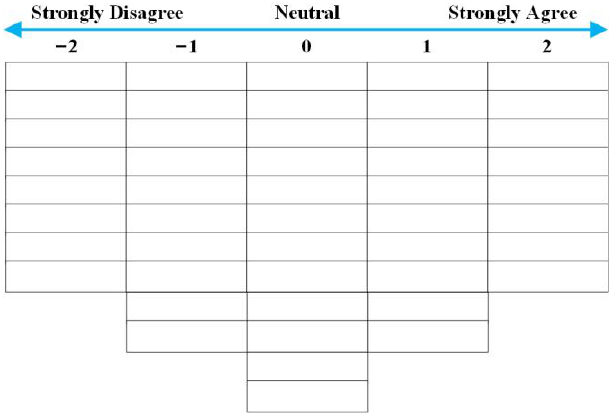
Figure 4. Q-sort grid of standard normal distribution.